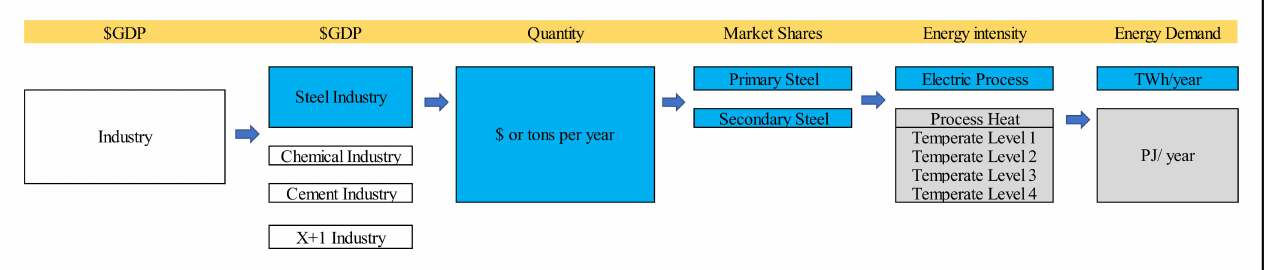
Figure 3. Calculation of Industry energy